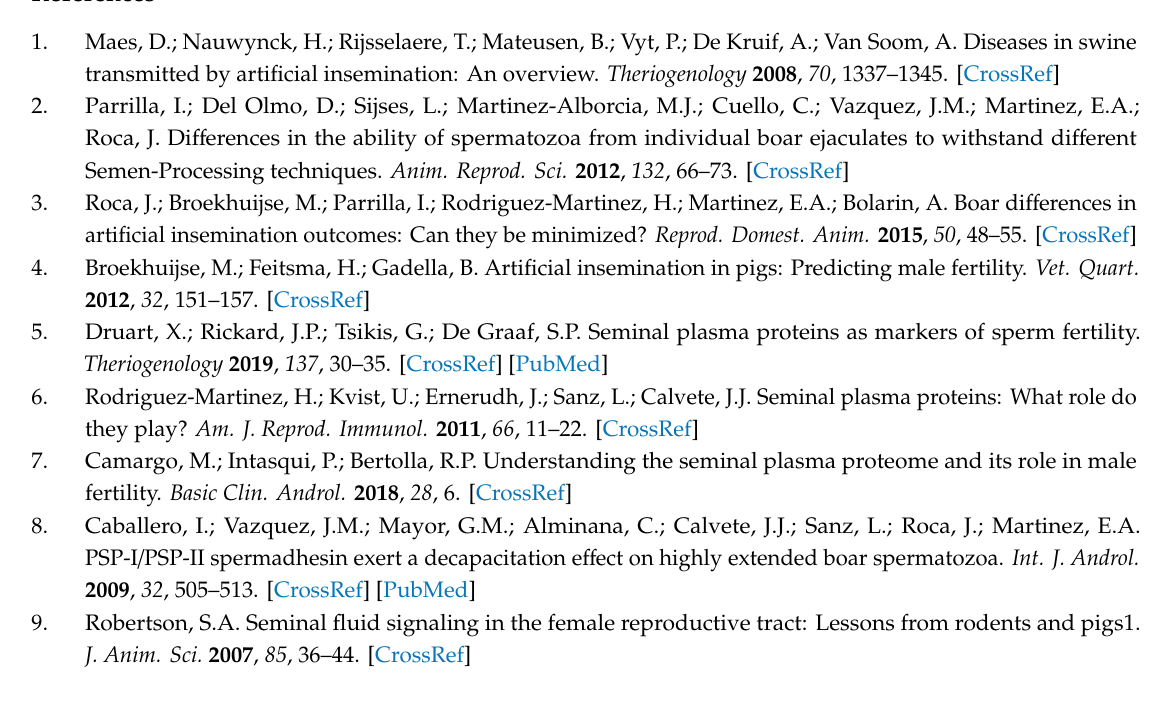
Figure S1: 1 H NMR spectra of seminal plasma obtained from di ff erent portions of the pig ejaculate (first 10 mL from the sperm-rich fraction [SRF-P1; A], the rest of sperm rich fraction [SRF-P2; B], the post-sperm-rich